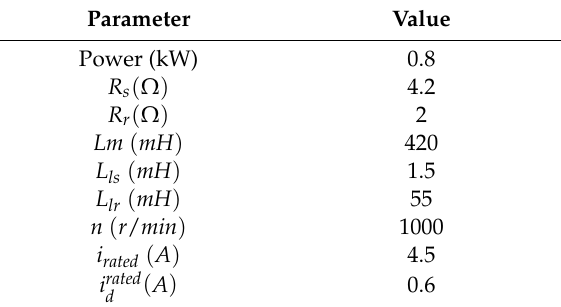
Figure 3. Employed test bench. Table 1. Induction machine drive